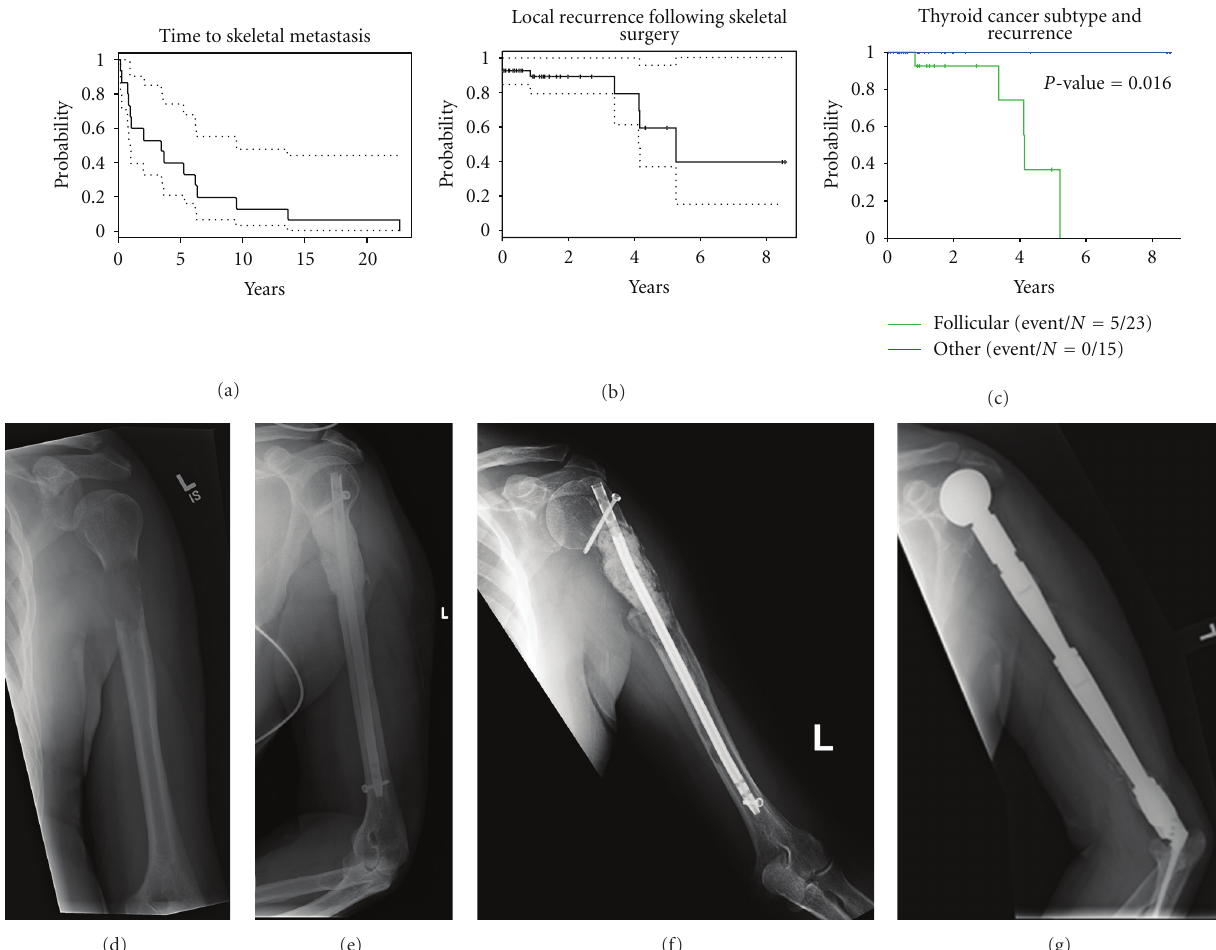
Figure 3: Progression of disease in bone. (a) Kaplan-Meier analysis of time to formation of skeletal metastasis. The median time to formation of bone metastasis after thyroid removal was 3.44 years. (b) Kaplan-Meier analysis of time to recurrence. The probability of recurrence free survival was 89% at 1 year (95% CI 80–100%), 60% at 5 years (95% CI 37–96%), and 40% at 8 years (95% CI 16–100%). (c) A diagnosis of follicular thyroid carcinoma was associated with a higher risk of recurrence versus other diagnoses (papillary, medullary, anaplastic, and Hurthle cell) ( P = 0 . 016). All recurrences following surgery for osseous metastasis were in patients with follicular thyroid carcinoma histo- logic diagnosis. (d) A patient with an impending fracture of the proximal humerus shaft from isolated metastasis from follicular thyroid carcinoma underwent open nailing with curettage and cementation. (e) Postoperative X-ray demonstrates a humeral nail and bone cement filling the defect created by curettage of the metastasis. (f) Follow-up X-ray 5 years after surgery showing increasing lytic changes in bone extending to the distal aspect of the humerus, consistent with local progression of disease. (g) Postoperative X-ray showing total humerus endoprosthesis. The humerus, intramedullary nail, and bone cement were resected en bloc. The total humerus endoprosthesis reconstruction has remained stable, and the patient remains alive with no sign of